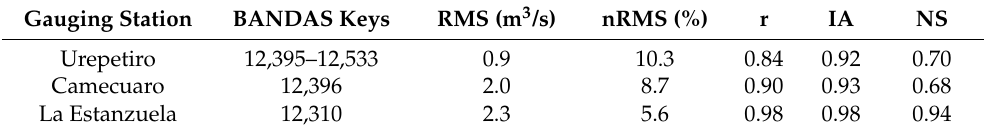
Table 1. Statistical summary of the WEAP model calibration (* n = 264).